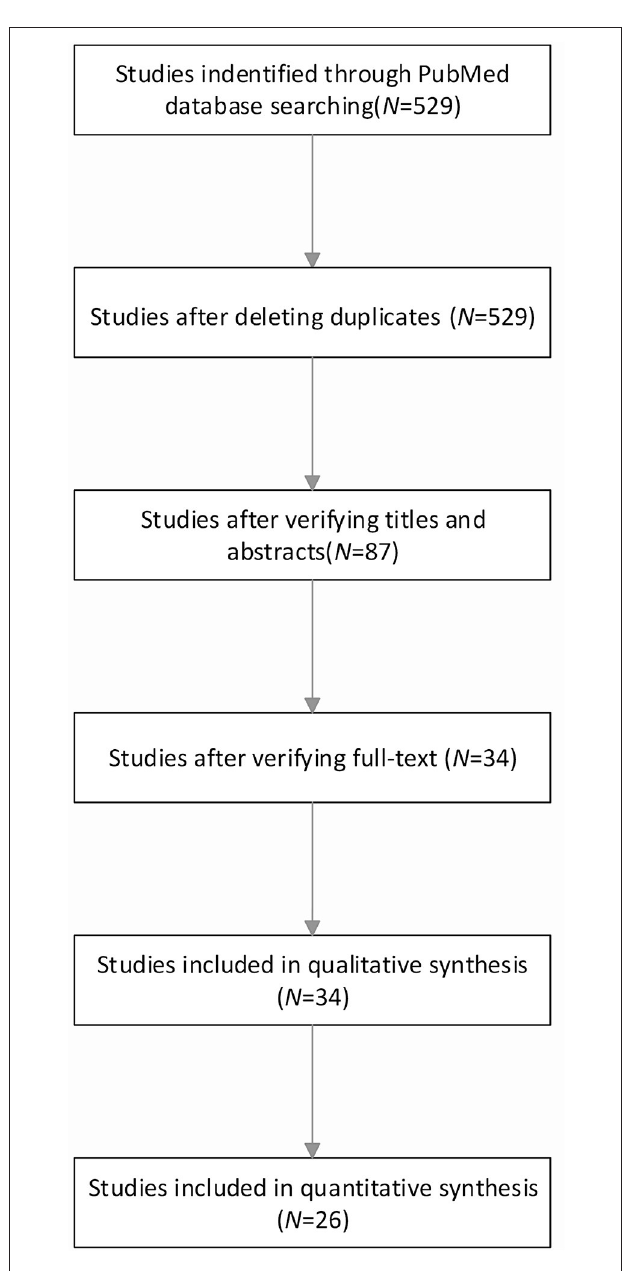
FIGURE 1 | Flowchart of study